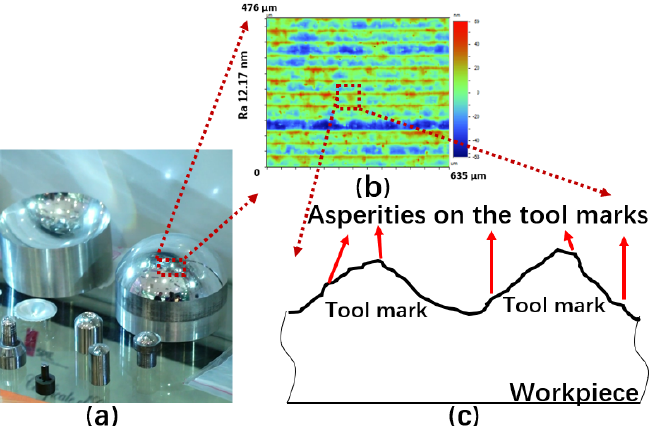
Figure 2. The aluminum alloy workpiece ( a ) looks shiny after SPDT but it actually has nanometer- level tool marks ( b ) on the surface. Asperities also exist on the tool mark ( c ).